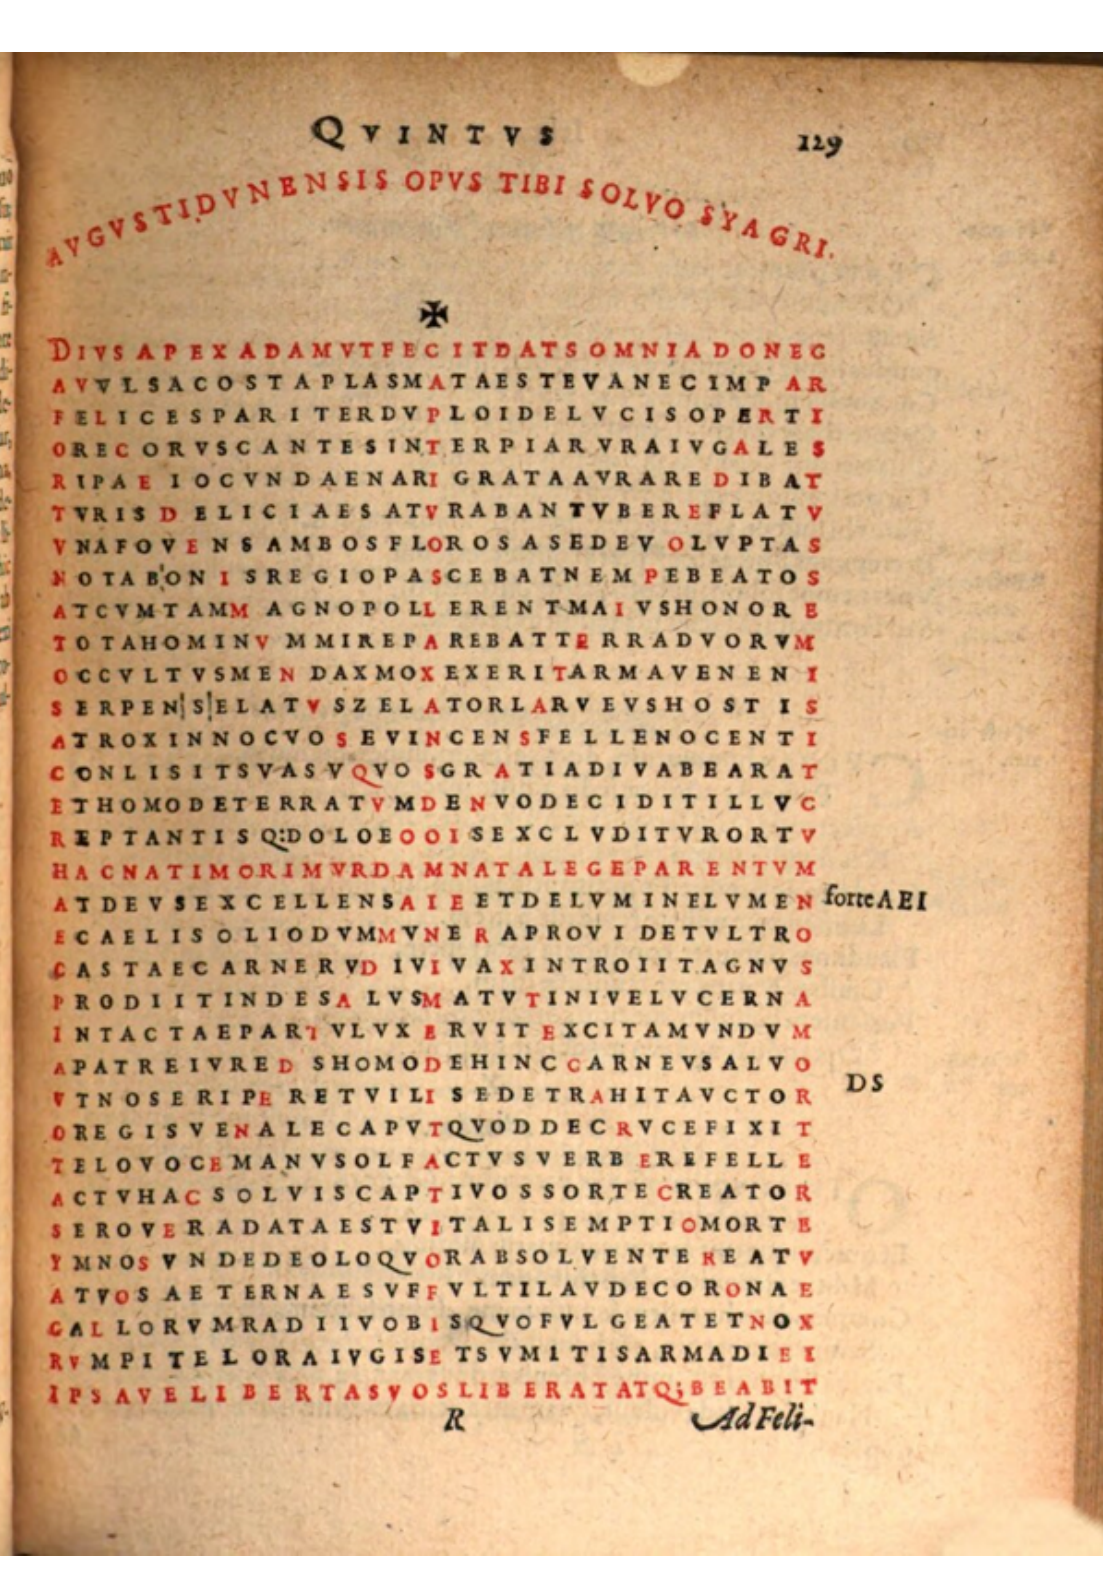
Figure 3 Bayerische Staatsbibliothek München, 4 P. lat. 426, S. 129, urn:nbn:de:bvb:12-